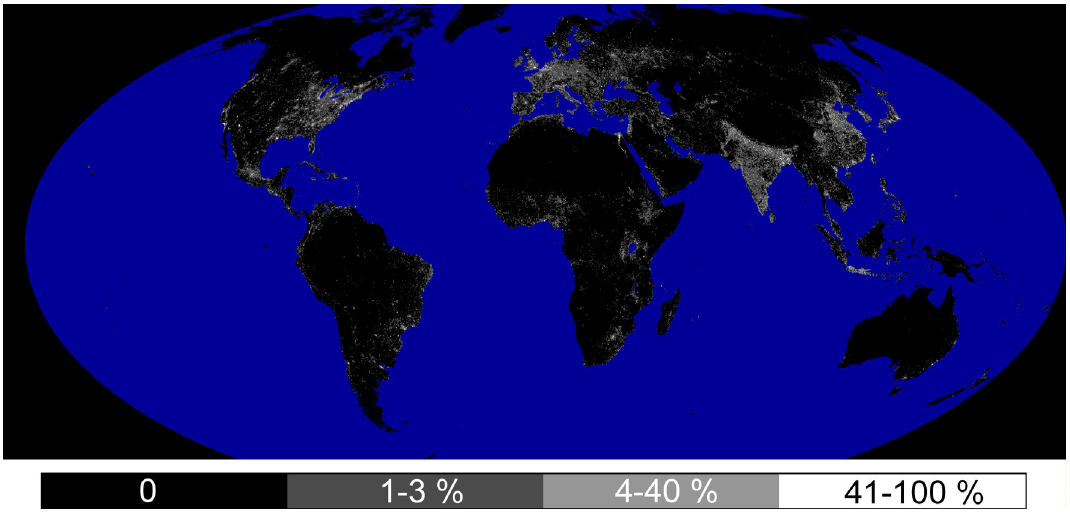
Figure 5. Global distribution and density of constructed impervious surfaces. Product is in a Mollweide 1 km 2 equal area grid. The figure shows the density of ISA in four gray scale